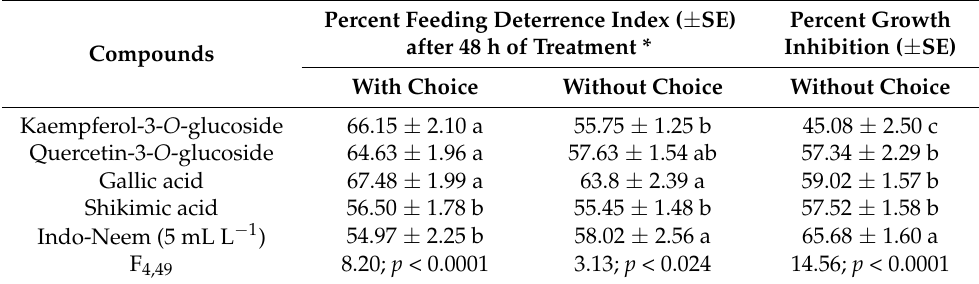
Table 4. Feeding deterrence of isolated compounds (4000 mg/L) of Triadica sebifera against P. xylostella . Percent Feeding Deterrence Index ( ± SE) Percent Growth after 48 h of Treatment * Inhibition ( ± SE) Compounds With Choice Without Choice Without Choice Kaempferol-3- O -glucoside 66.15 ± 2.10 a 55.75 ± 1.25 b 45.08 ± 2.50 c Quercetin-3- O -glucoside 64.63 ± 1.96 a 57.63 ± 1.54 ab 57.34 ± 2.29 b Gallic acid 67.48 ± 1.99 a 63.8 ± 2.39 a 59.02 ± 1.57 b Shikimic acid 56.50 ± 1.78 b 55.45 ± 1.48 b 8.20; p < 0.0001 14.56; p <